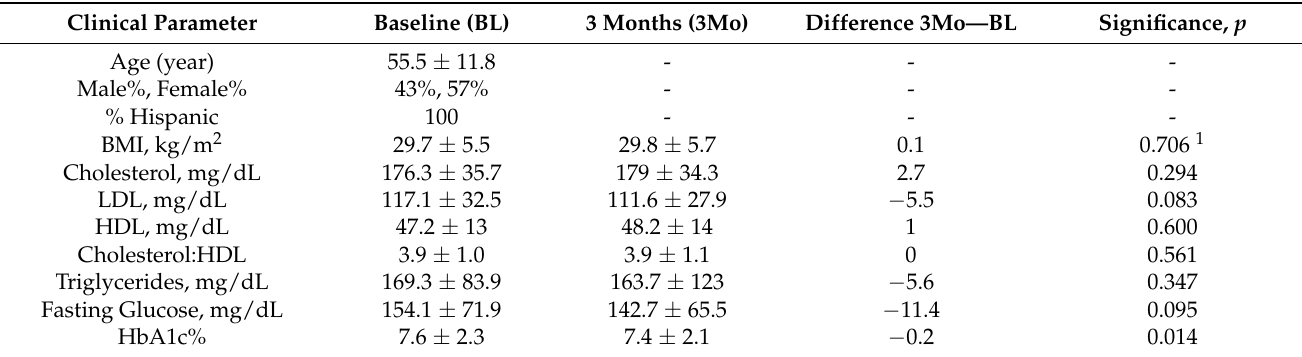
Table 1. Characteristics of study participants ( n = 35).